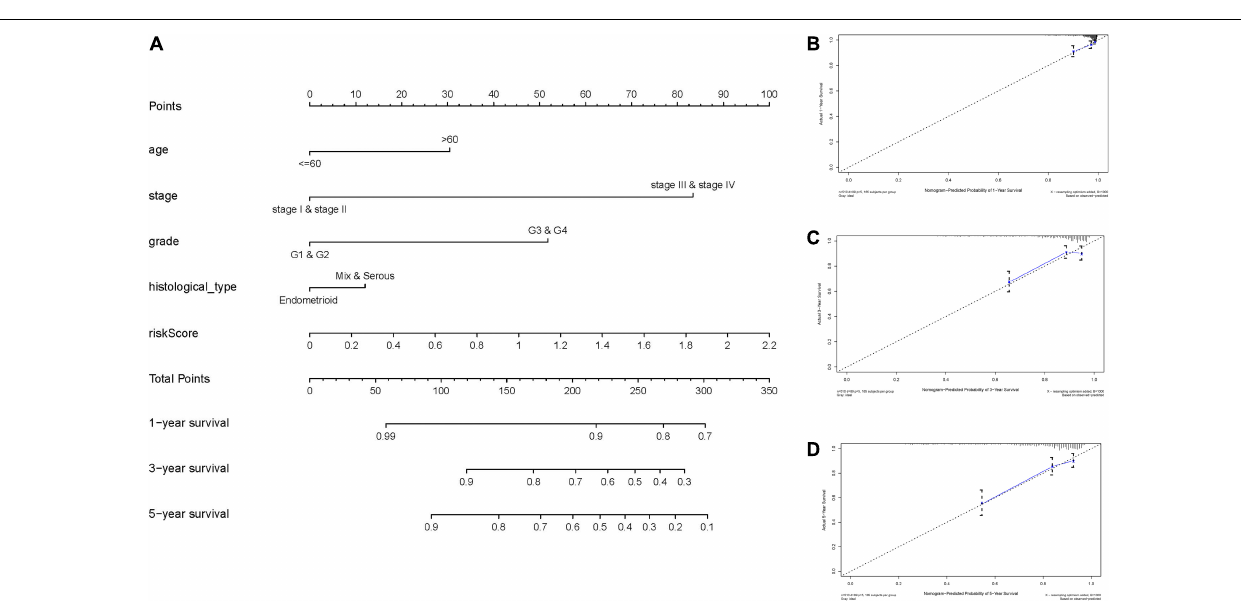
( Supplementary Figure 6B ), grade G1&G2 ( Supplementary Figure 6C ), grade G3&G4 ( Supplementary Figure 6D